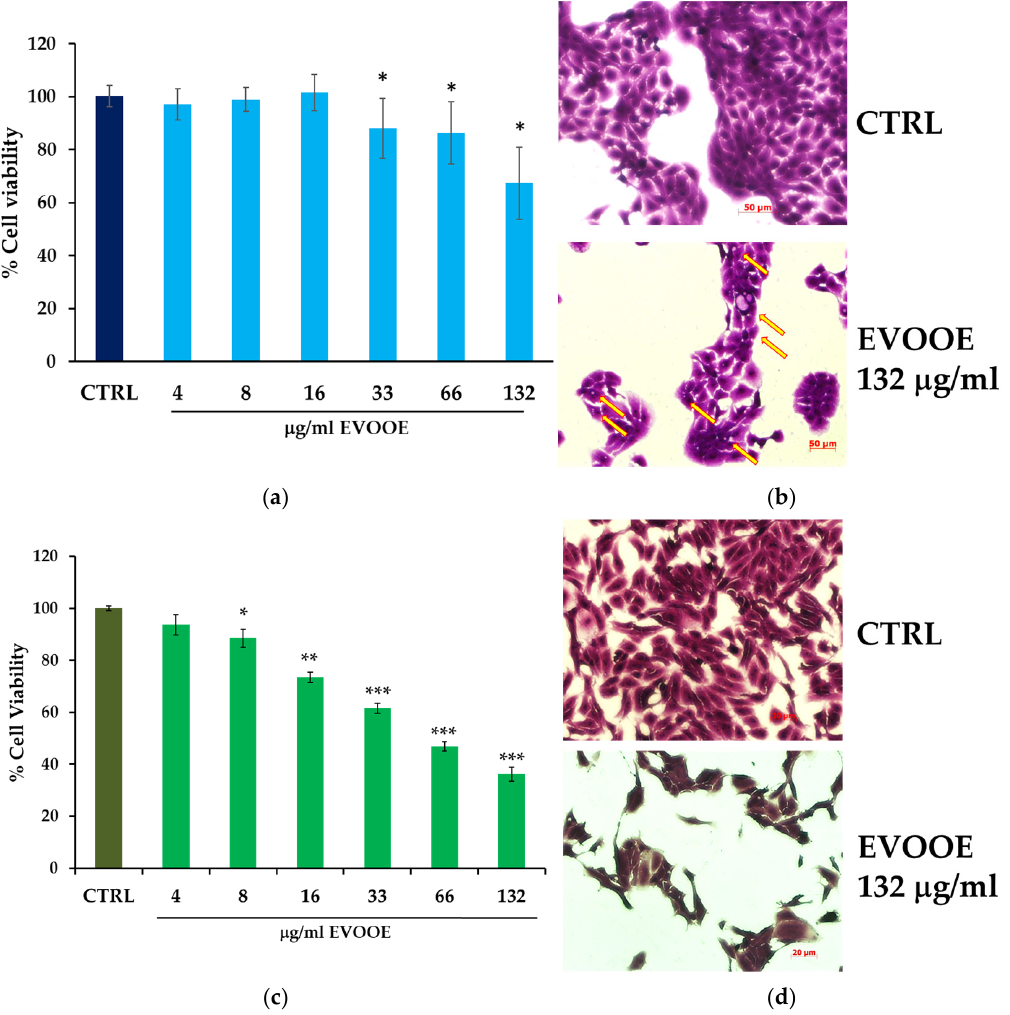
Figure 3. EVOOE stimulation effects on cell viability in RT112 and J82 cells. RT112 ( a ) and J82 ( c ) cells were stimulated with the indicated concentration of EVOOE ( w / v ) for 24 h. Cell viability was evaluated by Crystal Violet assay. Bar graphs represent the mean of three experiments ( ± s.e.). Symbols indicate significance: p < 0.05 (*), p < 0.0005 (**), and p < 0.0001 (***) with respect to CTRL (DMSO-treated cells). Panels ( b , d ) report representative images of RT112 and J82 cells, respectively, untreated (left) and treated (right) with the indicated concentrations of EVOOE and stained with Crystal Violet (optical microscope Axiovert 200 M Zeiss; 400 × or 200 × , bright field). The arrows in the lower panel in ( b ) indicate the presence of intracellular